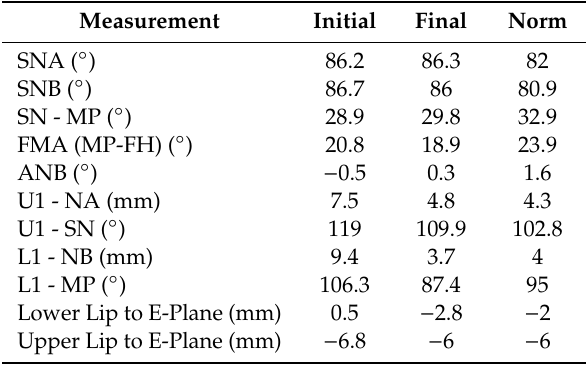
Table 1. Cephalometric analysis of before and after